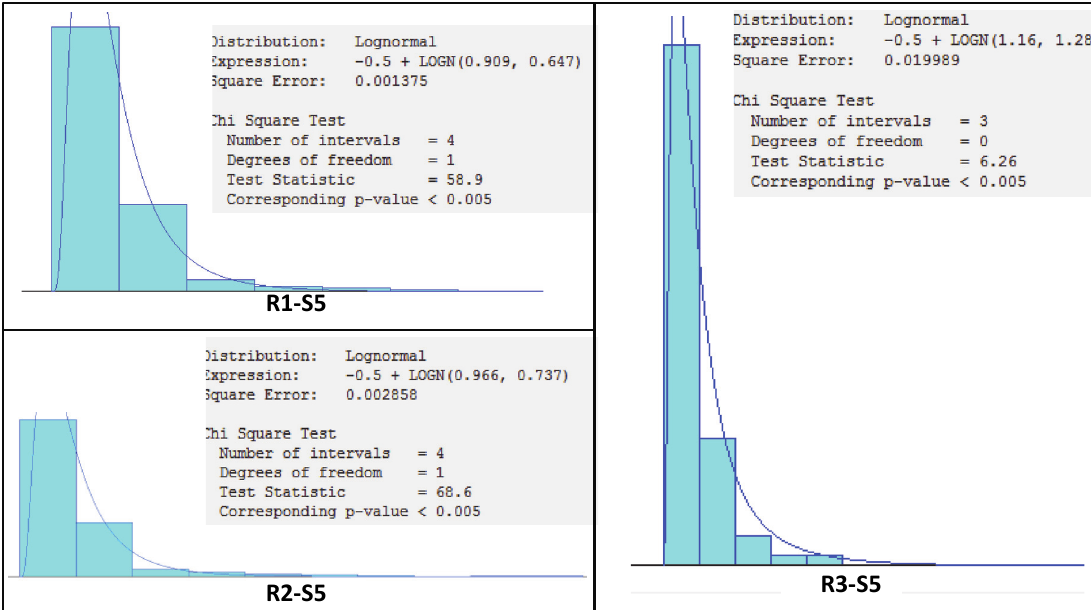
Fig. 6 . Probability curves for treatments of routes R1, R2, and R3 with timeslot